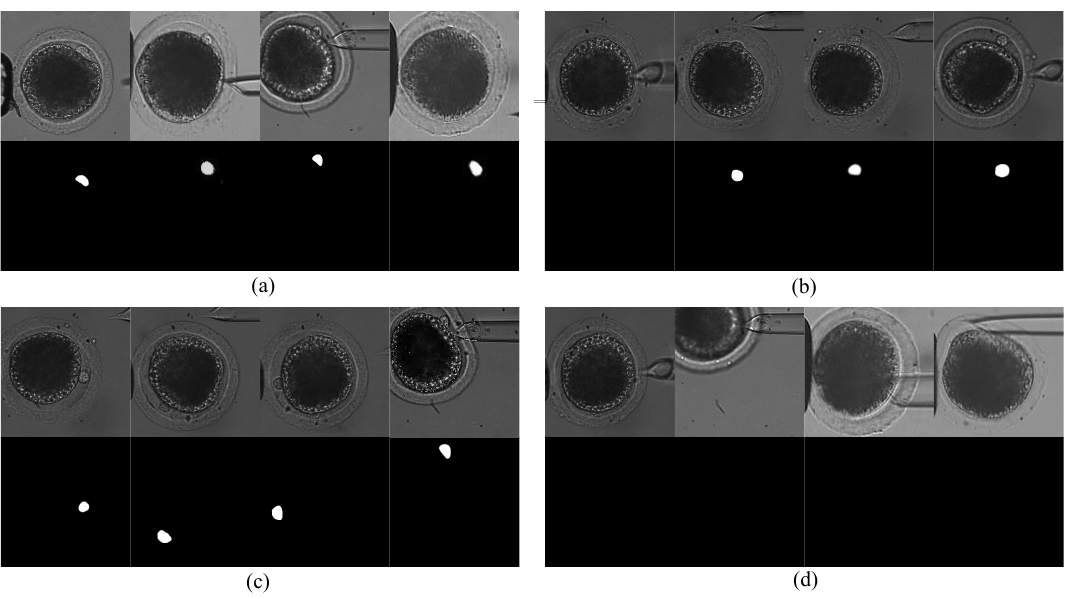
Figure 6. Examples of training data. ( a ) Polar-body images of different oocytes. ( b ) Polar-body images of the same oocyte in the first rotation stage. ( c ) Polar-body images of the same oocyte in the second rotation stage. ( d ) Oocyte images without a polar body as negative samples. Each union contains two rows. First row, oocyte images; second row, corresponding masks. White regions show the regions of the polar